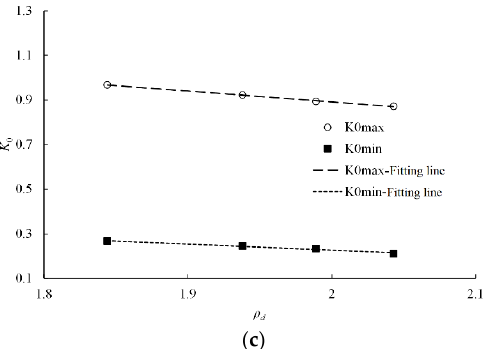
Figure 4. K 0max / K 0min – p d fitting curves: ( a ) loading stage; ( b ) unloading stage. ( c ) K 0max / K 0min – D r 0 fitting curves. Table 2. K 0max and K 0min of the tested specimens.